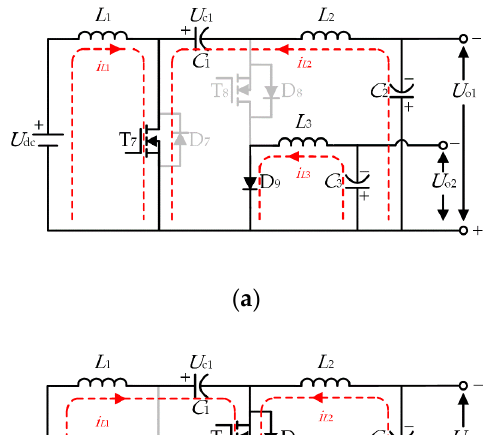
Figure 1. The BLDCM system driven by the SIDO Cuk converter.